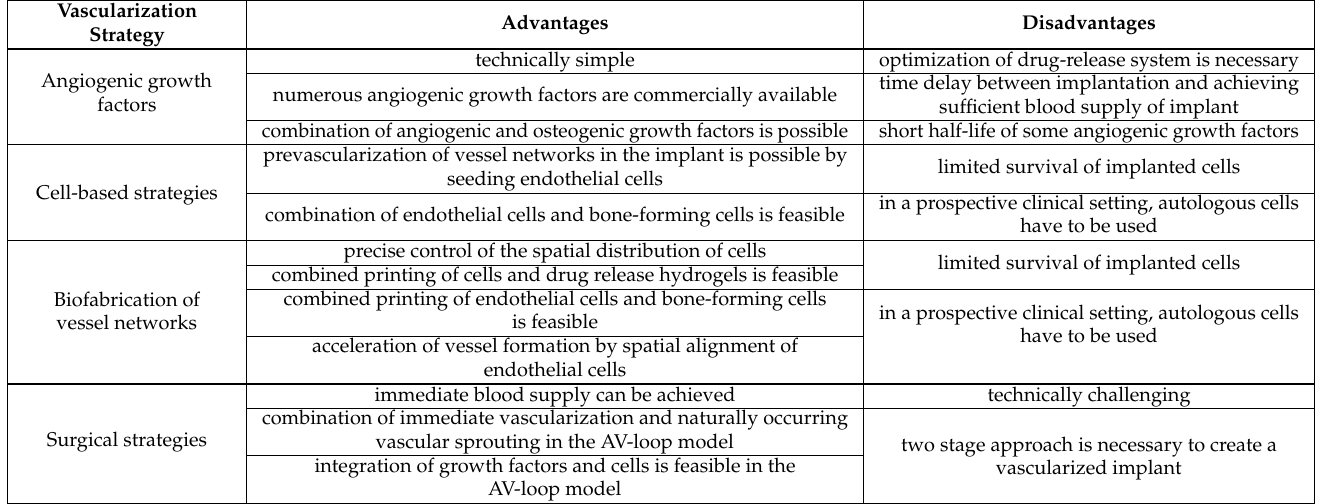
Table 1. Advantages and disadvantages of the various vascularization